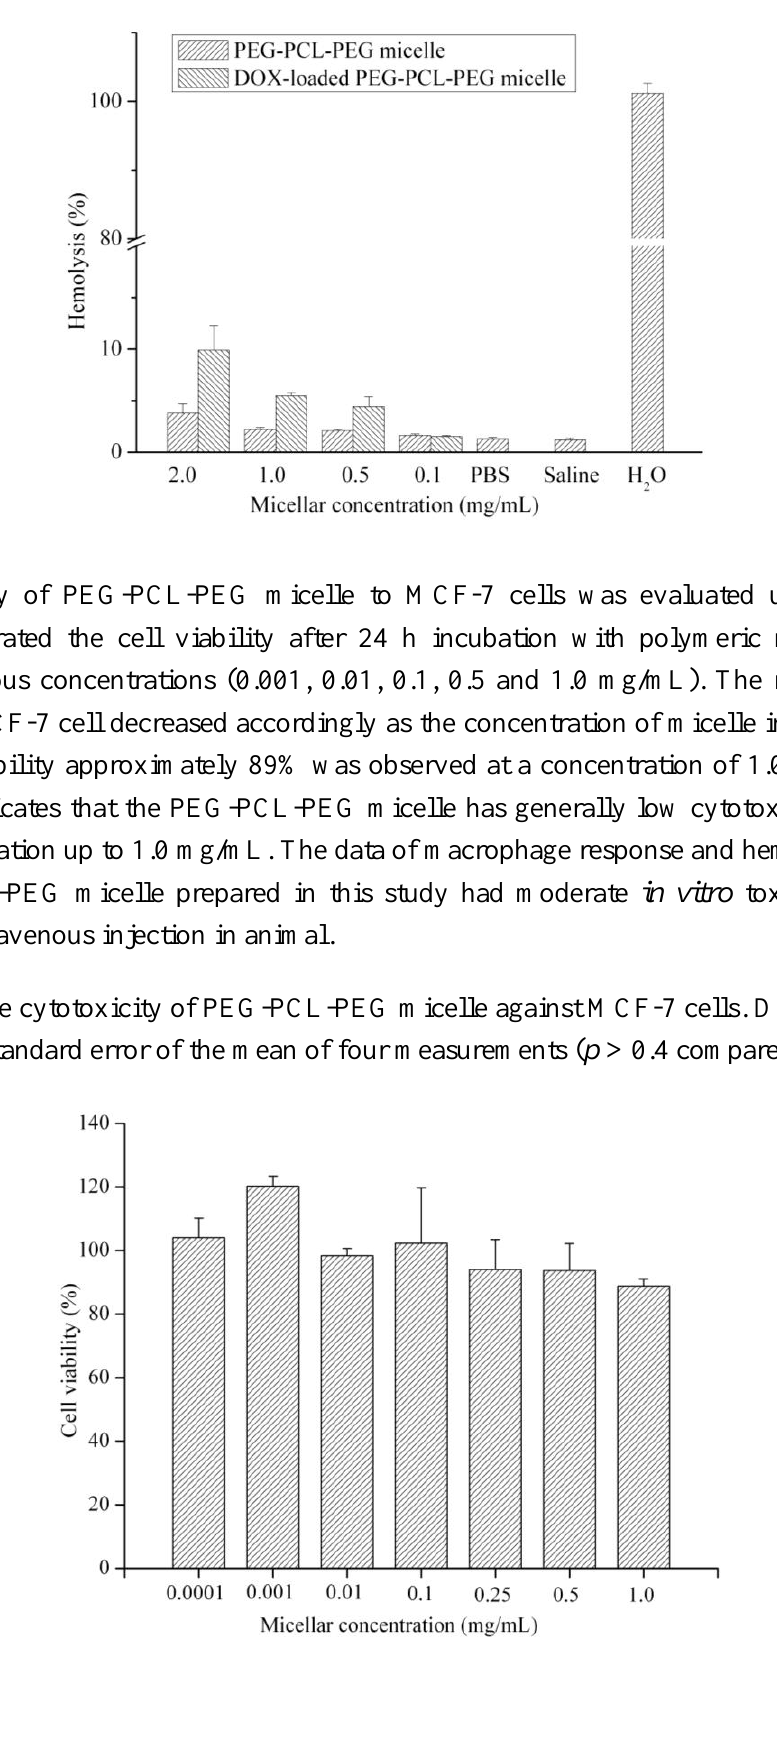
Figure 3. Hemolytic test on PEG-PCL-PEG micelle and DOX-loaded PEG-PCL-PEG micelle. Data represents the mean ± standard error of the mean of three experiments ( p < 0.01 compared to saline group).